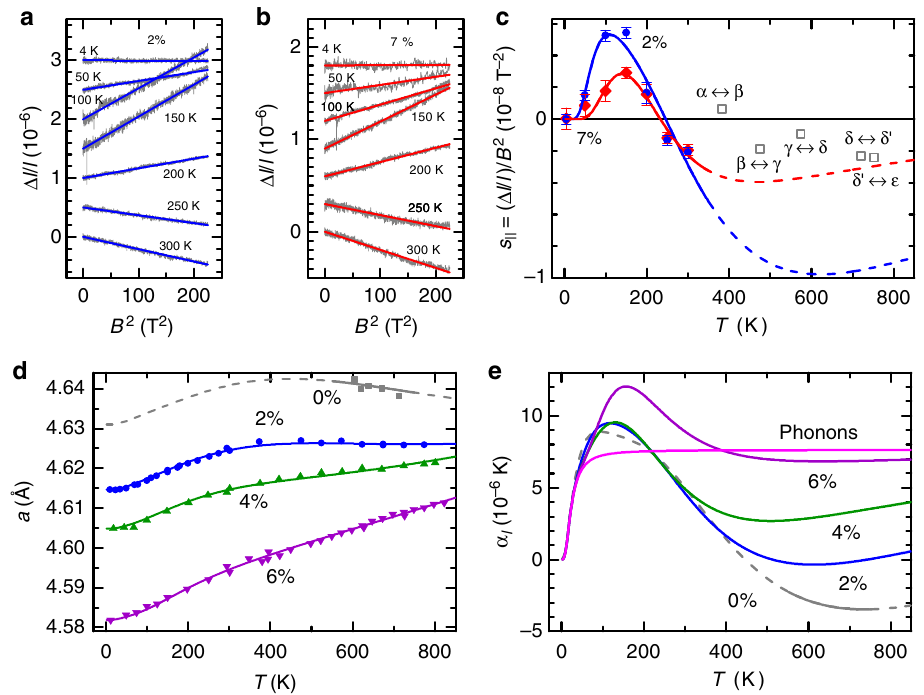
Fig. 1 Magnetostriction and thermal expansion of Ga-stabilized δ -Pu ( δ -Pu 1 − x Ga x ). a Longitudinal magnetostriction Δ l / l (gray lines) of x = 2% versus B 2 at several different temperatures together with quadratic fi ts (blue lines), where B is the magnetic fi eld. b Longitudinal magnetostriction (gray lines) of x = 7% versus B 2 at several different temperatures together with quadratic fi ts (red lines). c Longitudinal magnetostriction coef fi cient s || versus temperature for x = 2% (blue circles) and x = 7% (red diamonds). Error bars refer to the standard error of the mean, estimated by way of multiple sweeps. Open squares are the magnetovolume coef fi cient associated with each of the allotropic phase transitions in pure Pu, as described in the Results section. d Lattice parameter a versus T for x = 0% (gray squares), 2% (blue circles), 4% (green up triangles), and 6% (violet down triangles) from ref. 41 . e The thermal expansivity, obtained by applying α l = a T = 0 ( ∂ a / ∂ T ) to the fi tted lines in d . The phonon contribution calculated for a Debye temperature of θ D = 100 K 17 is shown for comparison (magenta). The global fi t to the data in c and d is discussed in the text and Methods, and is displayed using lines of the same color as the data points. Dashed lines indicate extrapolations